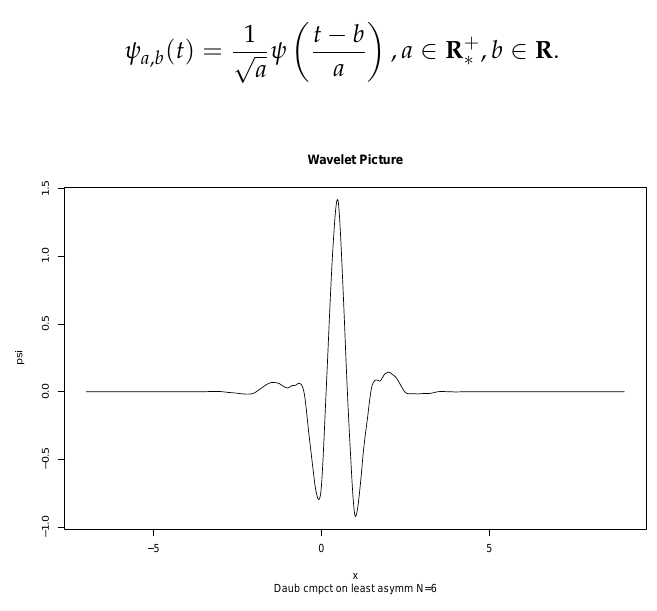
Figure 3. Daubechies least-asymmetric wavelet with filter size